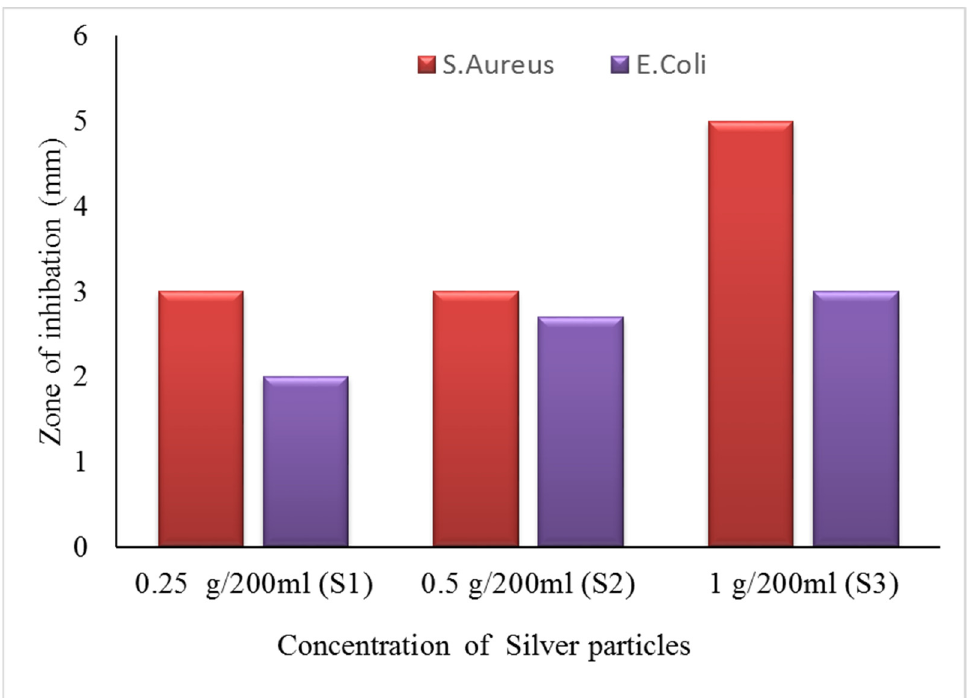
Figure 12. The average value of the zone of inhibition against silver particle-coated cotton fabric.